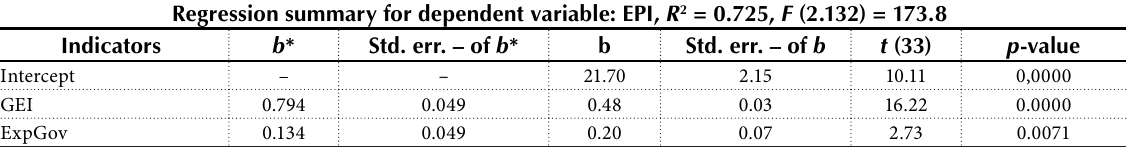
Table 7. Results of multiple nonlinear regression analysis: regressant – the country environmental state, regressors – the government efficiency and government expenditures in GDP